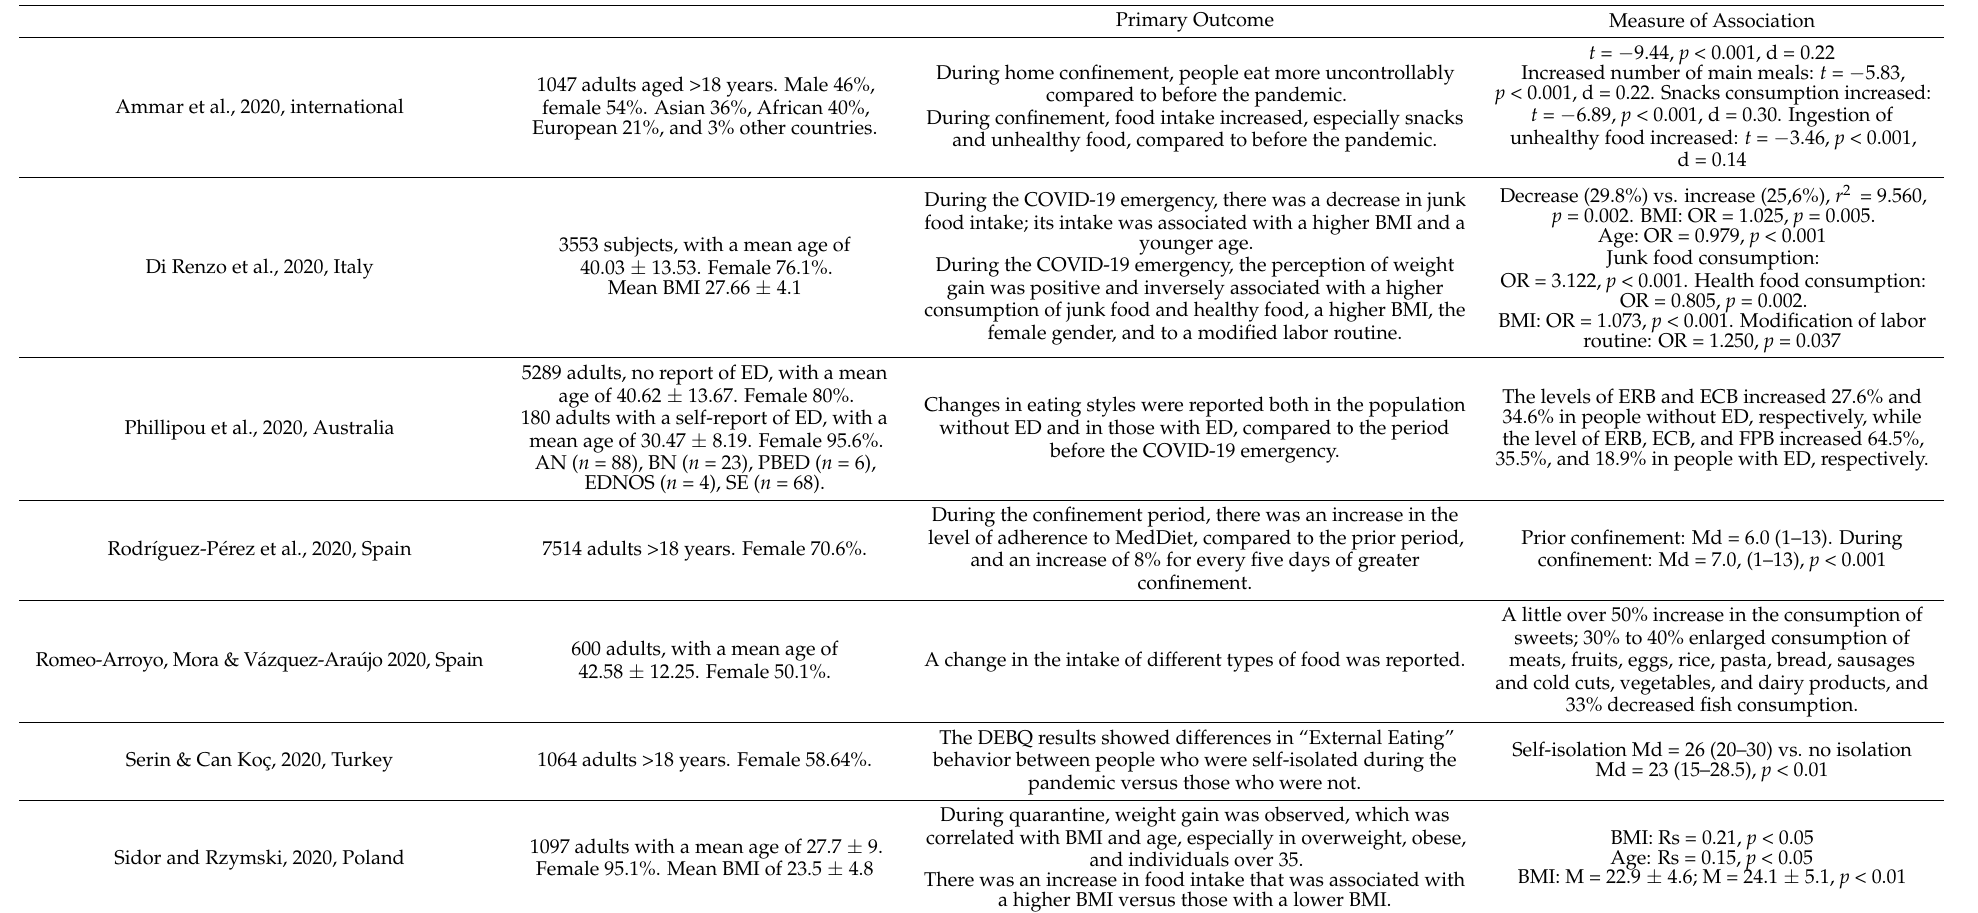
Table 1. Characteristics and primary results of cross-sectional